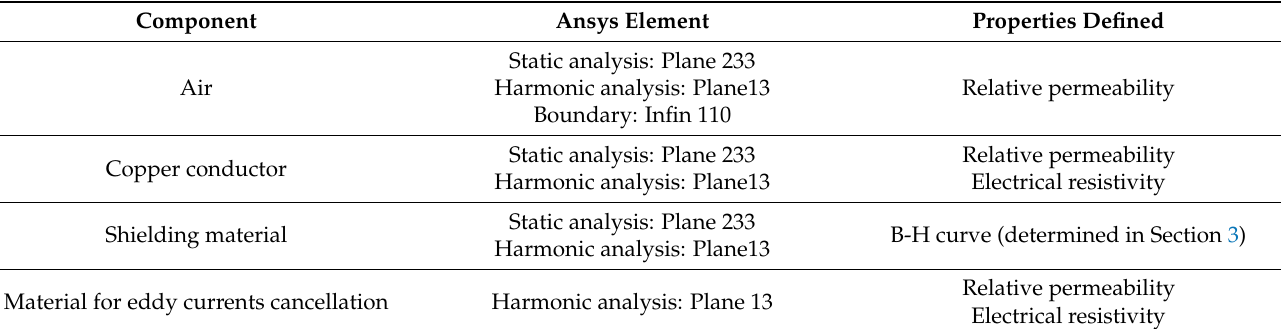
Figure 10. Illustration of the arrangement in the special cooling fixture.